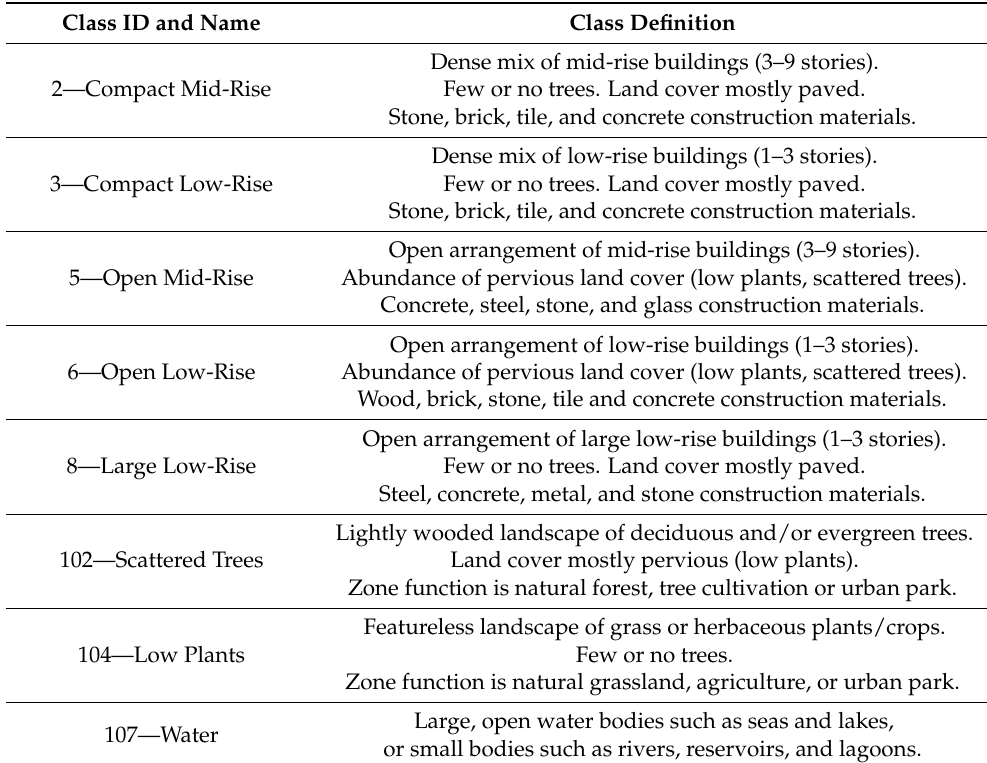
Table 2. Description of the LCZ classes identified in the Metropolitan City of